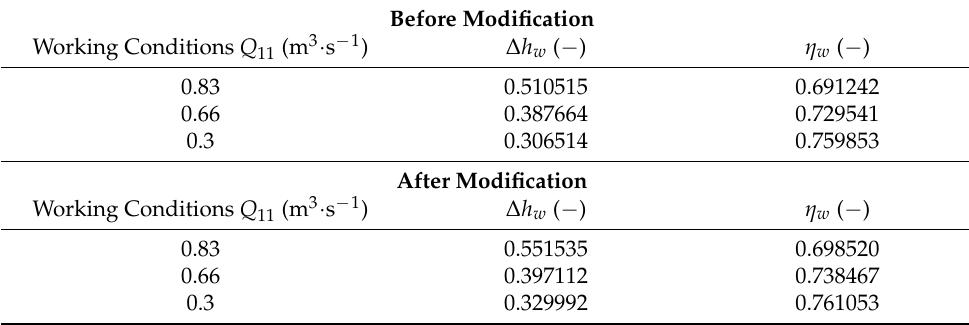
Table 6. Recovery coefficient of draft tube under different working conditions.